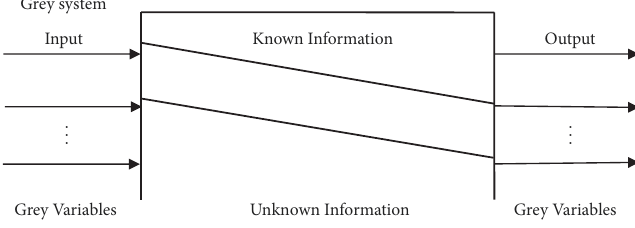
Figure 2. The concept of Grey System (source: Deng